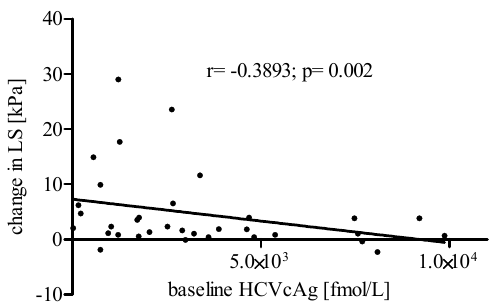
Figure 5. Correlation (Spearman’s rank correlation coefficient) between baseline HCVcAg levels and change in liver stiffness between baseline and FU96. HCVcAg—HCV core antigen; kPa—kilopascal; LS—liver stiffness; fmol—femtomoles.